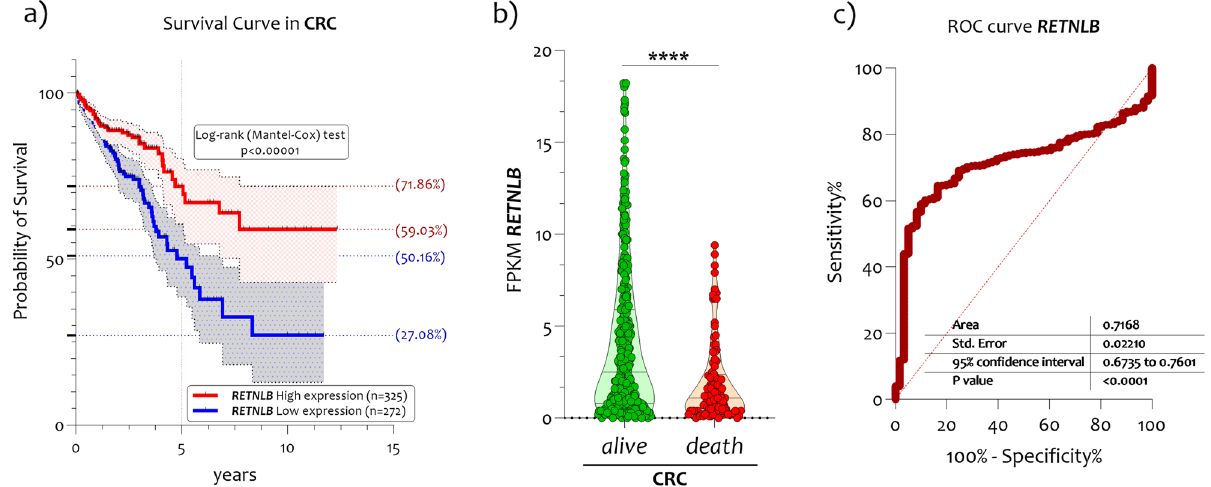
Figure 4. RETNLB expression levels correlate to the surviving of patients with CRC. ( a ) Kaplan–Meier plots of correlation between RETNLB mRNA expression level and patient survival; ( b ) Expression analysis in CRC patients as a function of 5-year survival; ( c ) High diagnostic ability of RETNLB (p < 0.00001, AUC = 0.7168) to discriminate the healthy subjects from CRC patients. The dashed lines indicate the maximum and minimum mean values. Data are expressed as z-score intensity expression levels (means and SD) and presented as dot plots. p values < 0.05 were considered as statistically significant (***p < 0.0001).